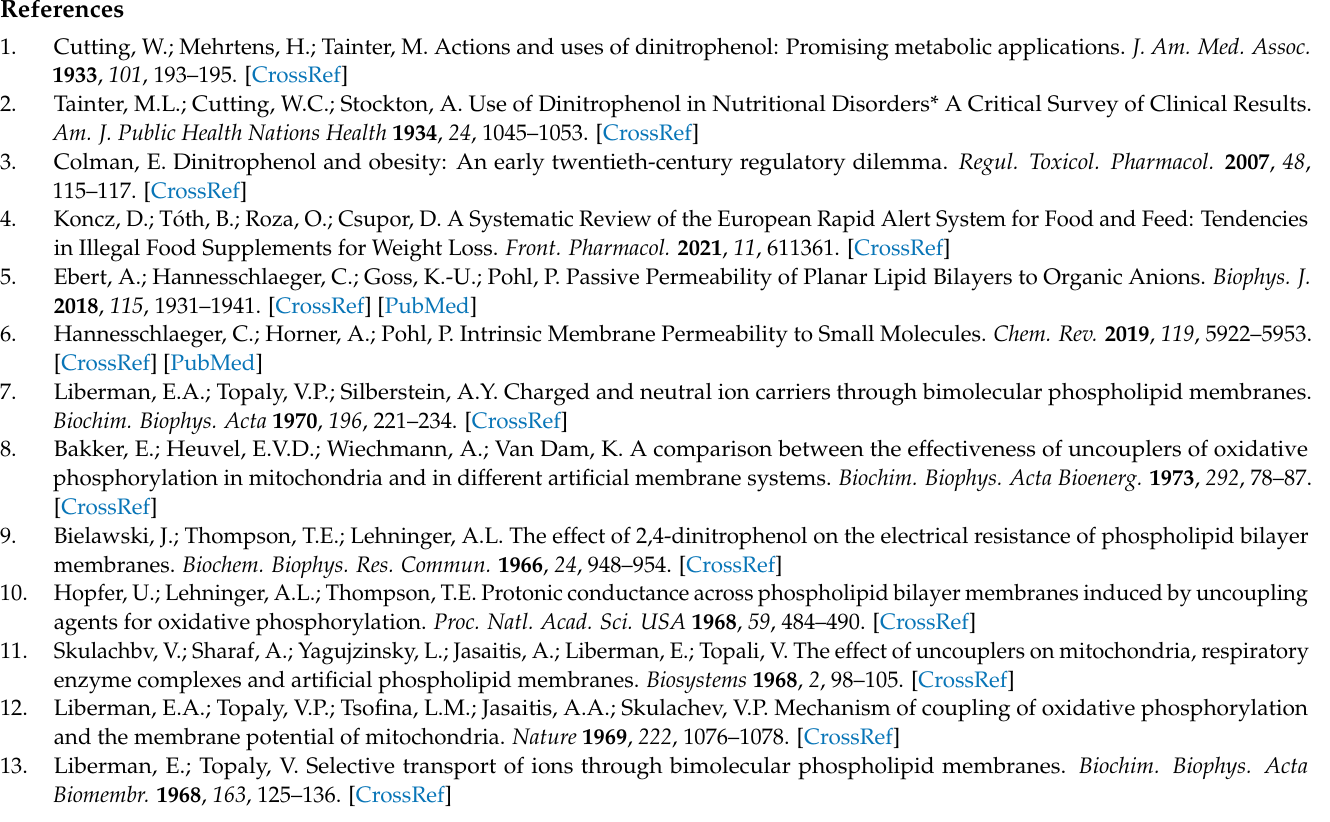
Figure S2: Representative current-voltage recordings of pure lipid bilayer membranes and membranes reconstituted with ANT1 or without ANT1 in the presence of DNP, Figure S3: Effect of ANT1 specific inhibitors on the total conductance (G m ) of membranes reconstituted with ANT1 and DNP, Figure S4: ATP binding to the arginine 79 of the ANT1 or ANT1-R79S, Figure S5: DNP and ATP binding in